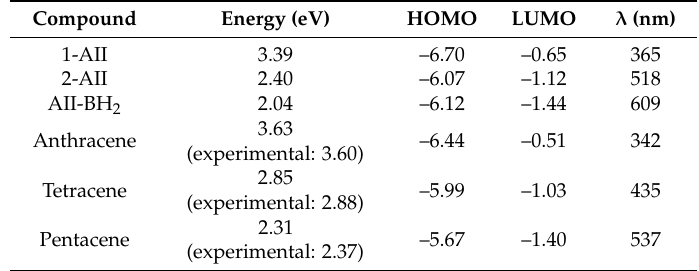
Table 4. The TD-(CAM-B3LYP/6-31G(d)) frontier orbitals—the highest occupied molecular orbital (HOMO) and the lowest unoccupied molecular orbital (LUMO)—HOMO-LUMO gap (eV), the frontier orbitals energies (eV), and the first vertical excitation wavelength of AII tautomers and selected